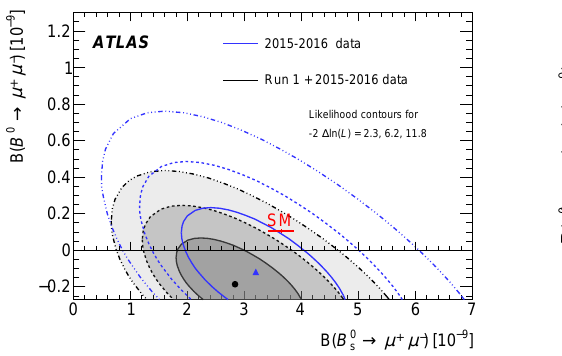
Figure 2: Likelihood contours for the results of the measurement of B ( B 0 (Left) Contours of the ATLAS measurement for values of − 2 ∆ ln ( L ) equal to 2.3, 6.2, 11.8 [ 4 ] . (Right) Contours of the combination of the ATLAS, CMS, and LHCb results for values of − 2 ∆ ln ( L ) = 2.3, 6.2, 11.8, 19.3, and 30.2 [ 6 ]